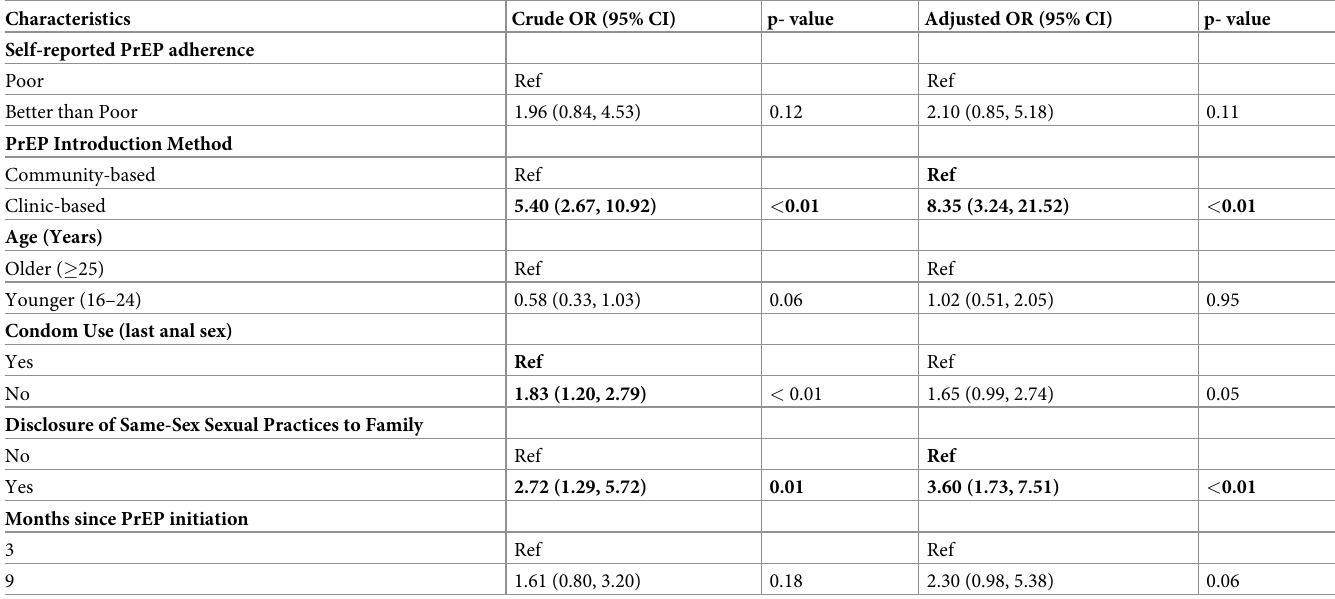
Table 3. GEE analysis of self-reported adherence and protective TFV concentration.